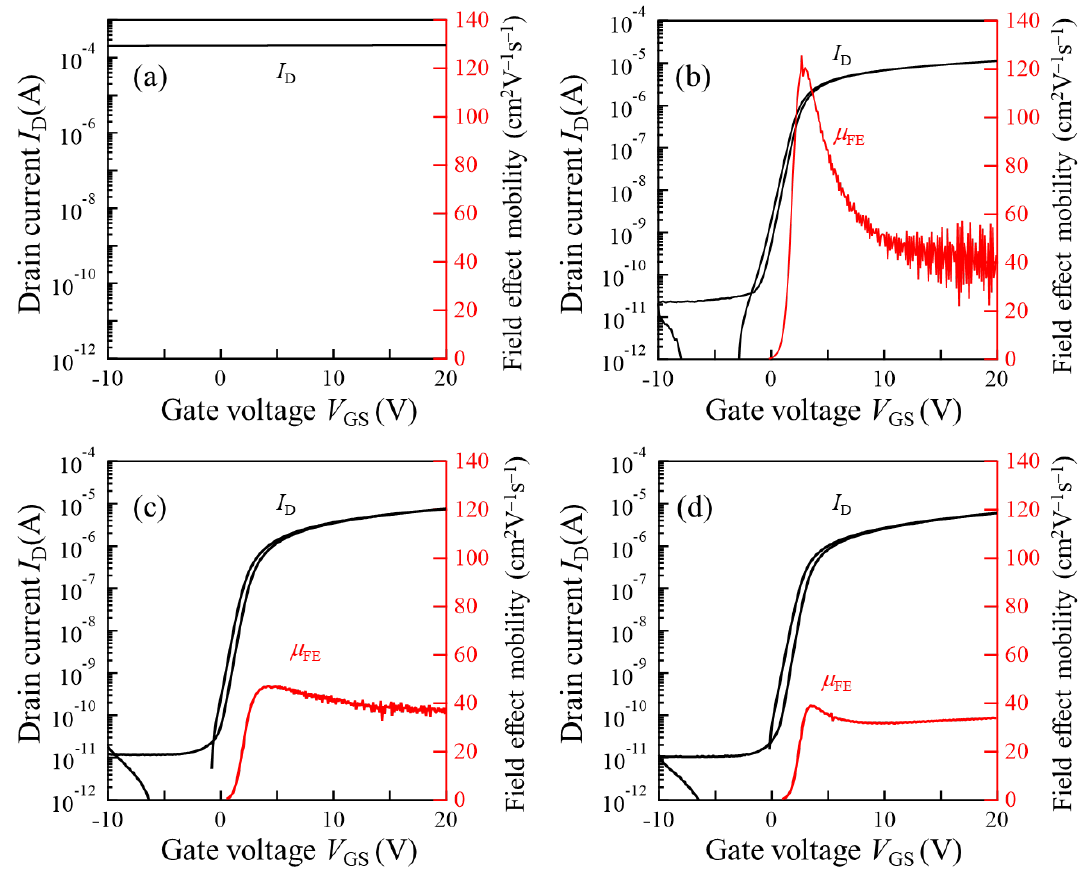
Figure 8. Transfer characteristics and field effect mobility of TFTs with ( a ) InO x [R(H 2 ) = 0] and InO x :H [R(H 2 ) = ( b ) 1, ( c ) 5, and ( d ) 9%] channels. A drain voltage of 0.1 V was applied.